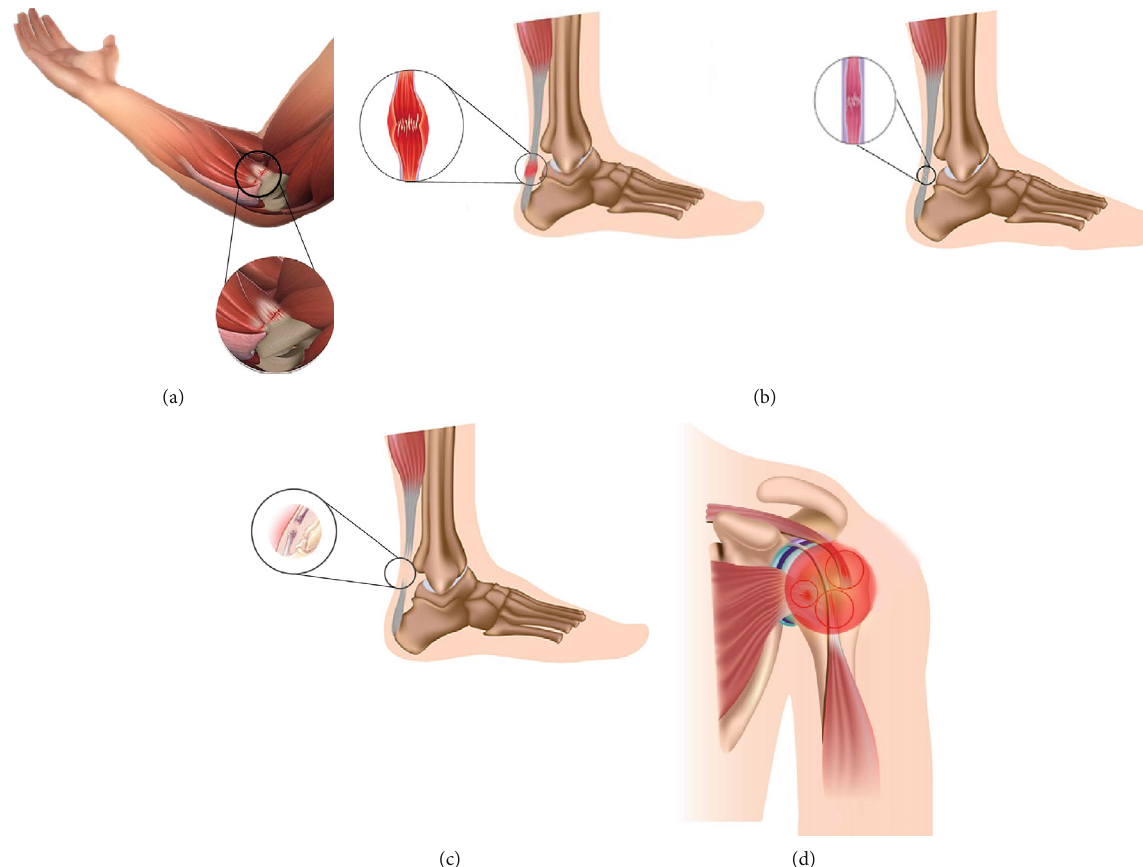
Figure 2: Major tendon injuries: (a) tendonitis, in fl ammation and irritation of tendon tissue, it is short term discomfort, usually caused by body ’ s immune response; (b) tendinosis, long term issue and chronic pain without in fl ammation, condition share many symptoms with tendonitis but greatly di ff erent in case and appearance, it is common in the shoulder, elbow, hip, knee and Achilles ’ tendons; (c) tendon rupture, acute condition, complete break o ff tendon tissue mainly because of overuse or unusual overload and exercise, surgical intervention; (d) rotator cu ff injury, tear o ff rotator cu ff tendon that stabilize shoulder, acute condition. Reproduced with permission from references [31 –